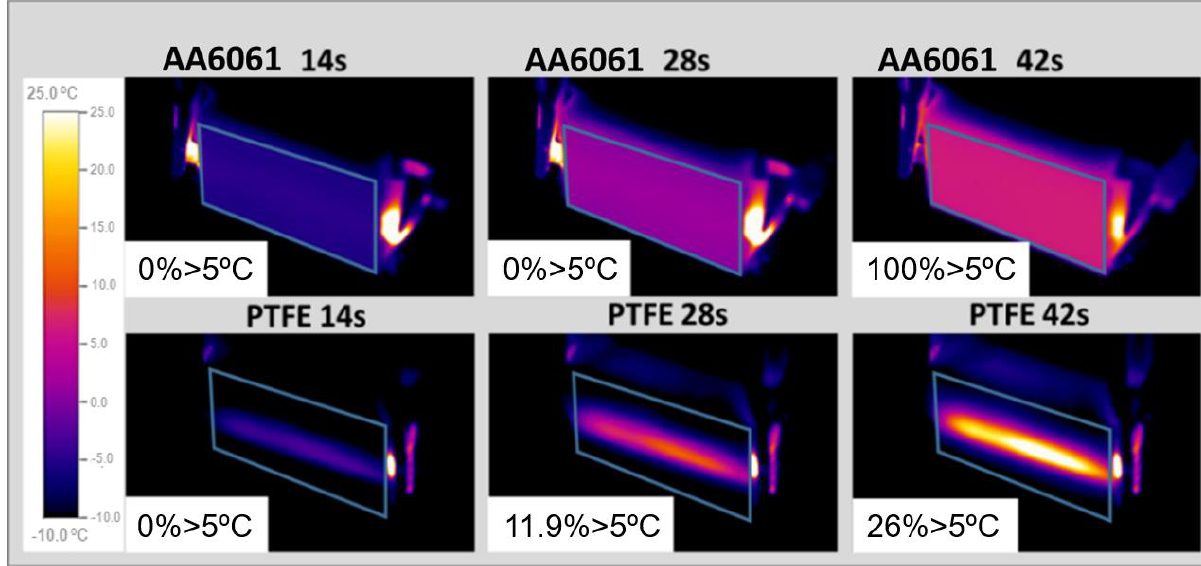
Figure 7. Time-lapse images show the homogeneous heating in Al (Top images) and the thermal heterogeneity of PTFE (bottom).